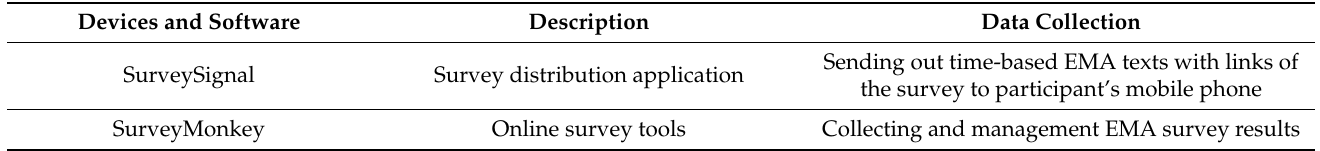
Table 2. The configuration of the ecological momentary assessment (EMA) collection